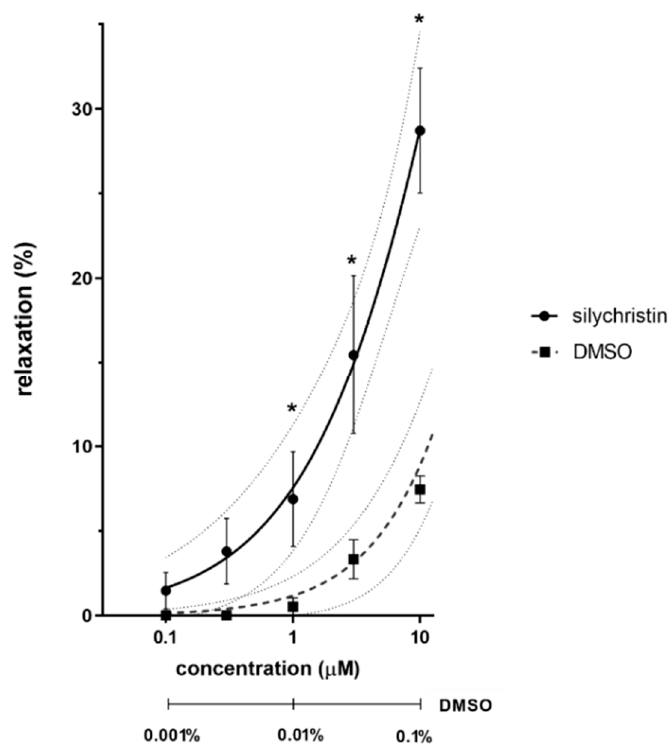
Figure 2. Vasodilatory effect of silychristin on aortic rings precontracted with phenylephrine. The percentage of relaxation was calculated using the standard vasorelaxant drug sodium nitroprusside, which produces 99% vasorelaxation at 10 µM. Data are expressed as means ± SEM, n = 5. The concentration of DMSO is shown below the x axis. * p < 0.05 vs. DMSO.